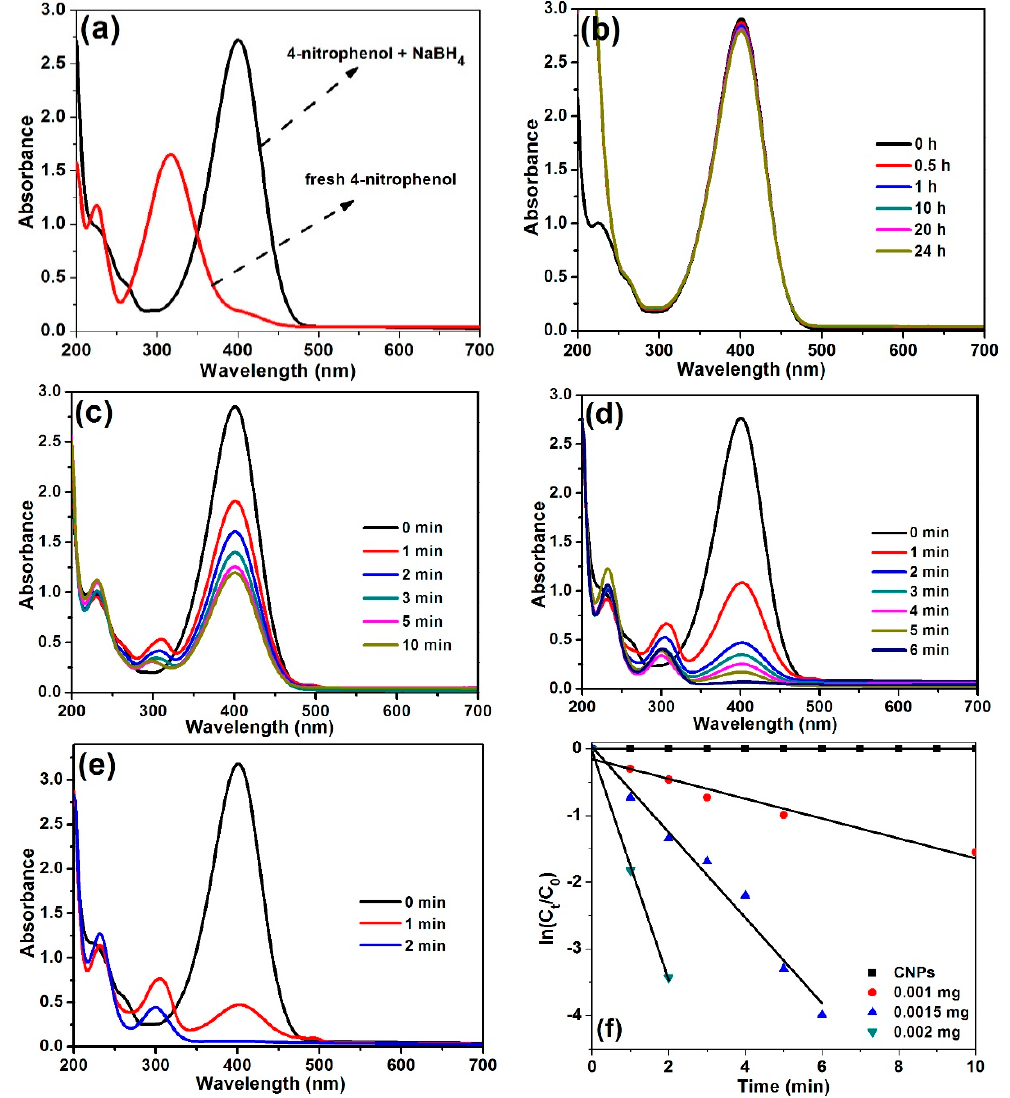
Figure 7. Spectra: ( a ) 4-nitrophenol before and after addition of NaBH 4 , ( b ) GNPs catalyzed reduction of 4-nitropehenol with NaBH 4 , ( c – e ) reduction of 4-nitrophenol using different amount of 4-nitropehenol with NaBH 4 , ( c – e ) reduction of 4-nitrophenol using di ff erent amount of Rh(0)NCs / GNPs Rh(0)NCs/GNPs (0.001, 0.0015 and 0.002 mg). ( f ) Plots of ln[C t /C 0 ] versus reaction time for the (0.001, 0.0015 and 0.002 mg). ( f ) Plots of ln[C t / C 0 ] versus reaction time for the reduction of reduction of 4-nitrophenol with NaBH 4 over the different amounts of Rh(0)NCs/GNPs.